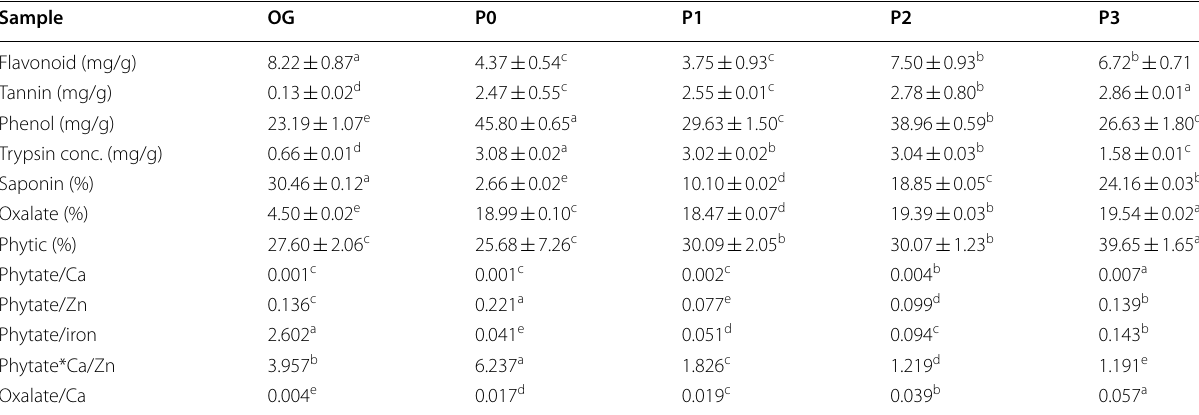
Table 5 Anti-nutritional composition and phytate/mineral molar ratios (mol/kg) of therapeutic complementary foods